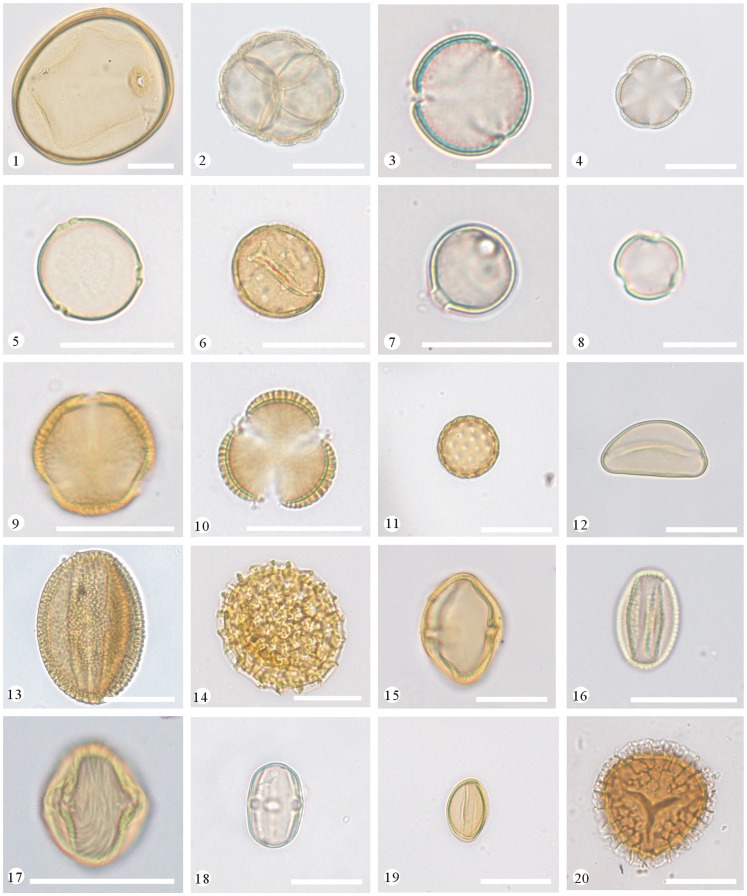
Photomicrographs of selected pollen grains recovered from the honey samples.1. Poaceae type, 2. Catalpa ovata (Bignoniaceae), 3. Ranunculaceae type, 4. Laminaceae type, 5. Humulus sp. (Moraceae), 6. Juglans regia (Juglandaceae), 7. Glycine max (Fabaceae), 8. Sophora japonica (Fabaceae), 9. Ailanthus altissima (Simaroubaceae), 10. Brassicaceae type, 11. Chenopodiaceae type, 12. Allium sp. (Liliaceae), 13. Fagopyrum esculentum (Polygonaceae), 14. Polygonaceae type, 15. Rhus sp. (Anacardiaceae), 16. Salix sp. (Salicaceae), 17. Prunus sp. (Rosaceae), 18. Melilotus suareolens (Fabaceae), 19. Vitex negundo var. heterophylla (Verbenaceae), 20. Lycopodium sp. (Lycopodiaceae) (Scale bar = 20 µm for Nos. 1, 2, 4–7, 9–20, = 10 µm for Nos. 3, 8).